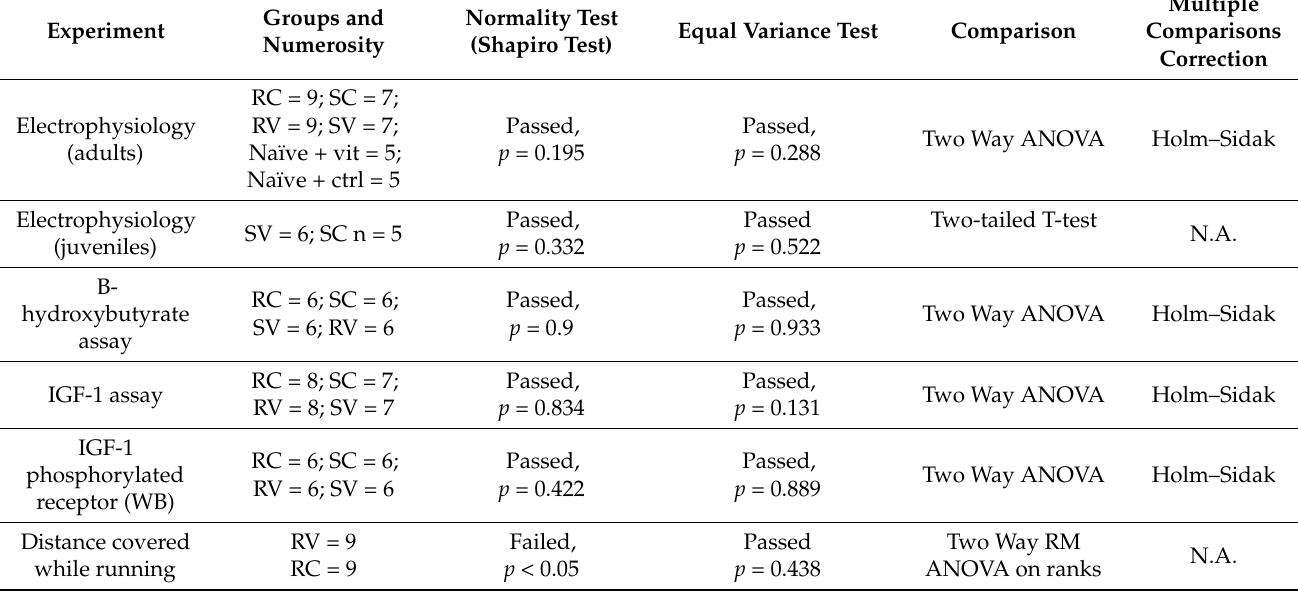
Table 1. Statistical analysis